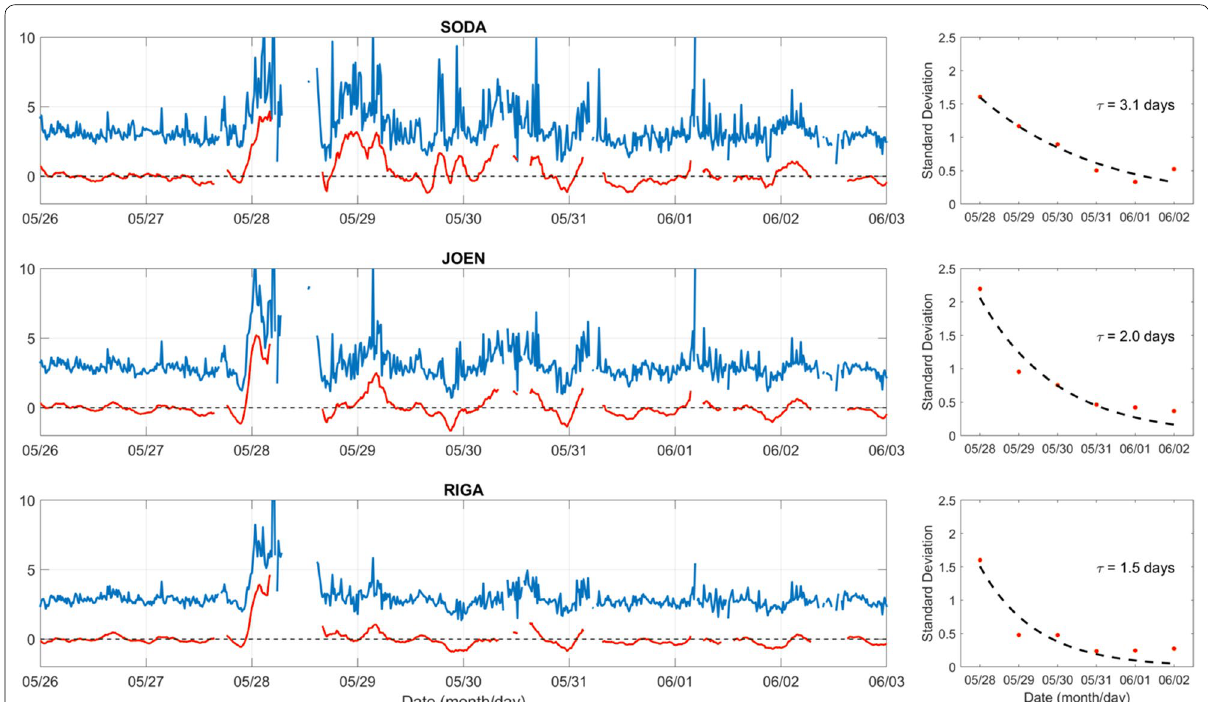
Fig. 12 The ratio tTEC / bTEC (in blue) as calculated at SODA (67.4°N, 26.4°E), JOEN (62.4°N, 30.1°E), and RIGA (56.9°N, 24.1°E), from 26 May to 2 June 2017, in UT. SODA, JOEN and RIGA are the closest GNSS receivers to the pairs of magnetometers MUO–RAN, RAN–HAN and TAR–BRZ of the EMMA array, respectively, used to describe the latitudinal dependence of the plasmasphere dynamics as shown in Fig. 7. Corresponding 2 h and half running means to which the mean value of 26 May 2017, considered as the quiet time reference, has been subtracted, are also displayed in red. In the right panels, the daily standard deviations related to the red curves, from 28 May to 2 June 2017, are plotted and fitted through an exponential function y A e ( − t / τ ) , where τ is a characteristic time typifying the recovery phase of the ionospheric = ·